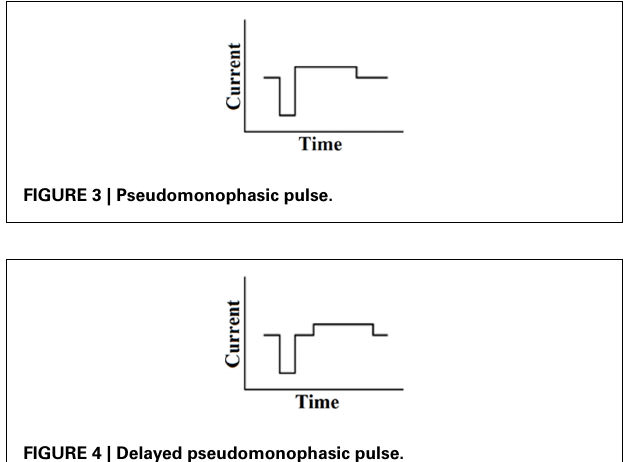
FIGURE 4 | Delayed pseudomonophasic pulse.